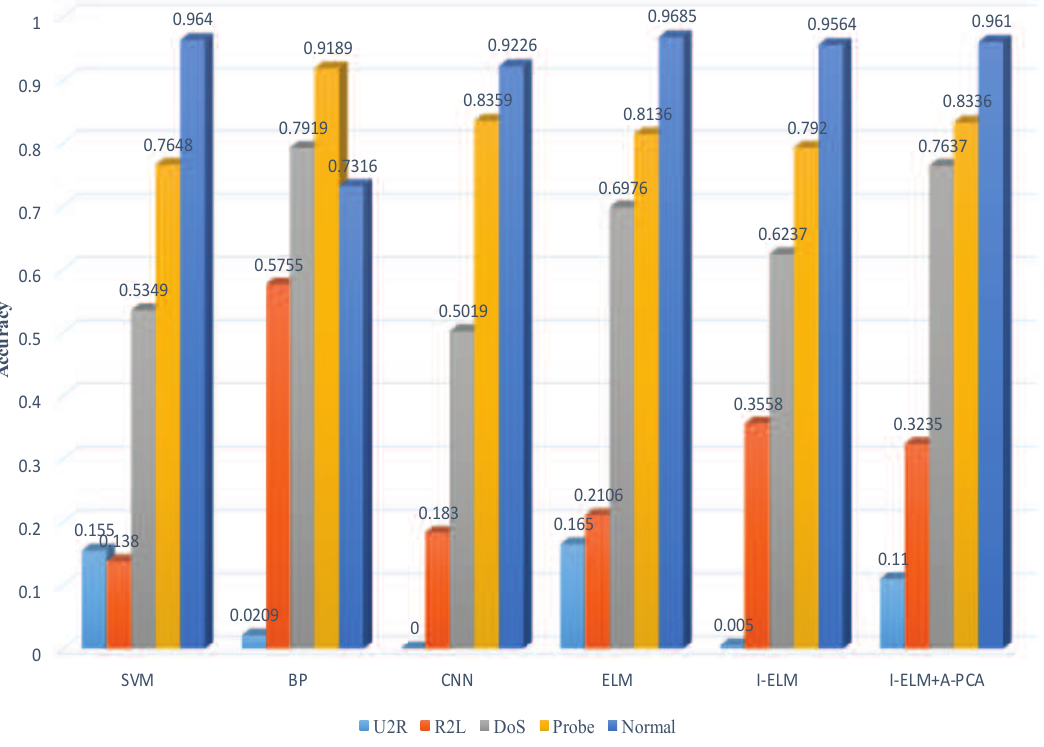
Figure 6. The confusion matrices analysis of different methods (NSL-KDD).